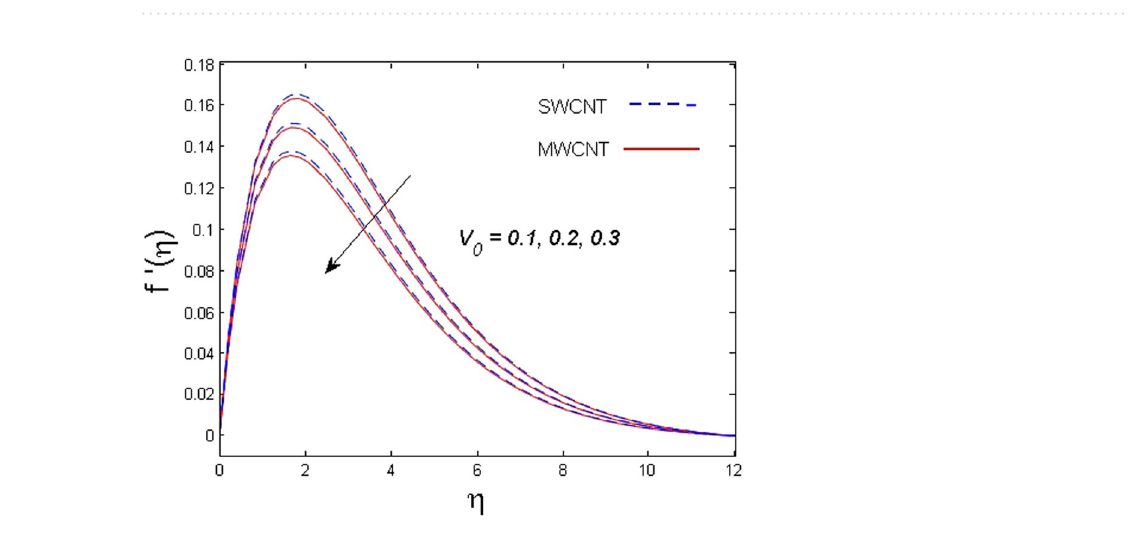
Figure 4. Outcome of k 1 on f ( ) η ′ .